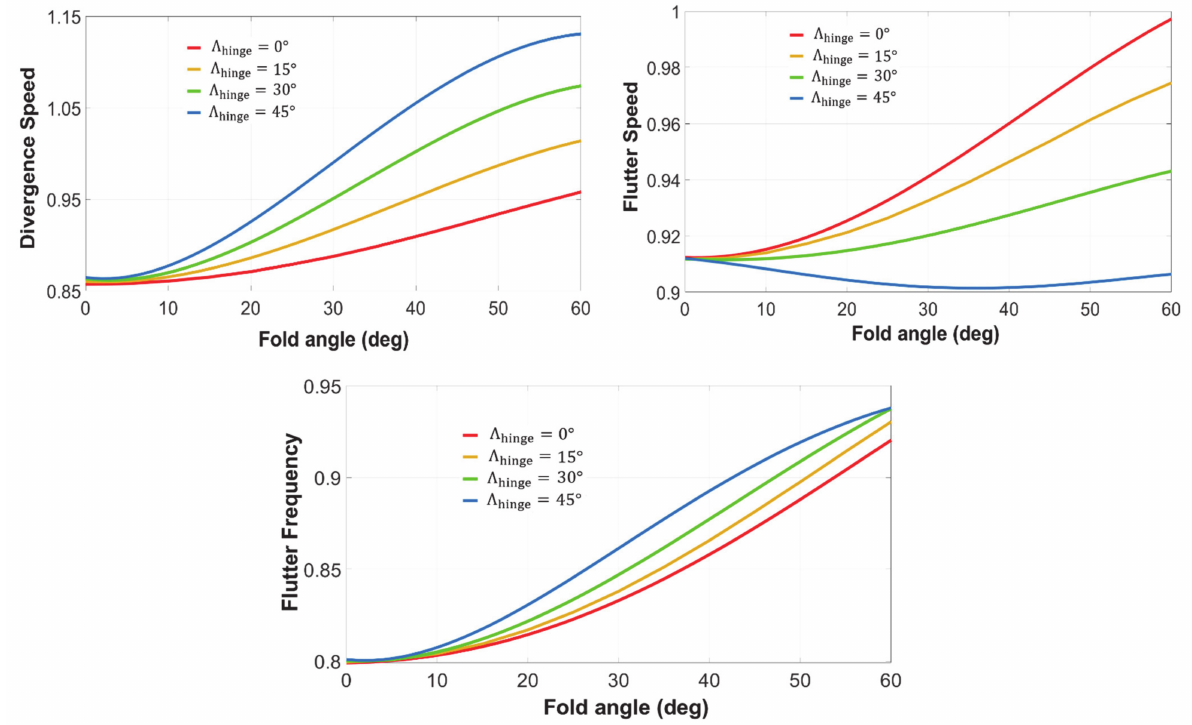
Figure 11. Variation of aeroelastic parameters for a wingtip length of 1.016